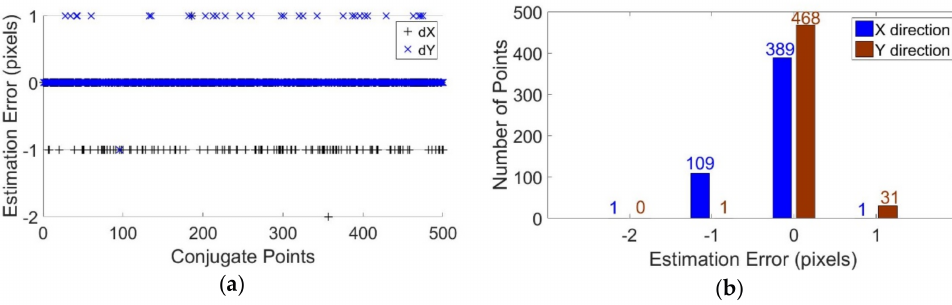
Figure 8. Estimation accuracy for approximate positions of conjugate points at the third pyramid level of the HRSC Level-3 images for orbit 4165: ( a ) scatter chart; and ( b ) histogram